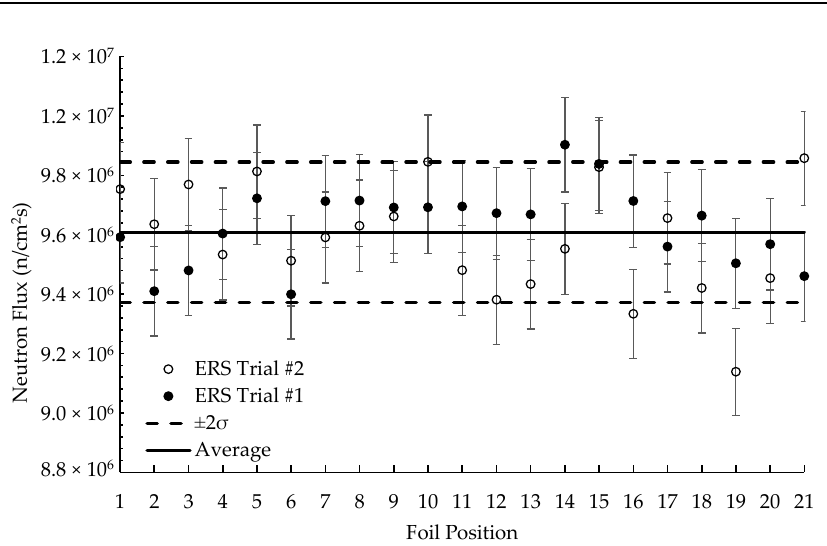
Figure 4. Neutron flux as a function of position on the image plane.